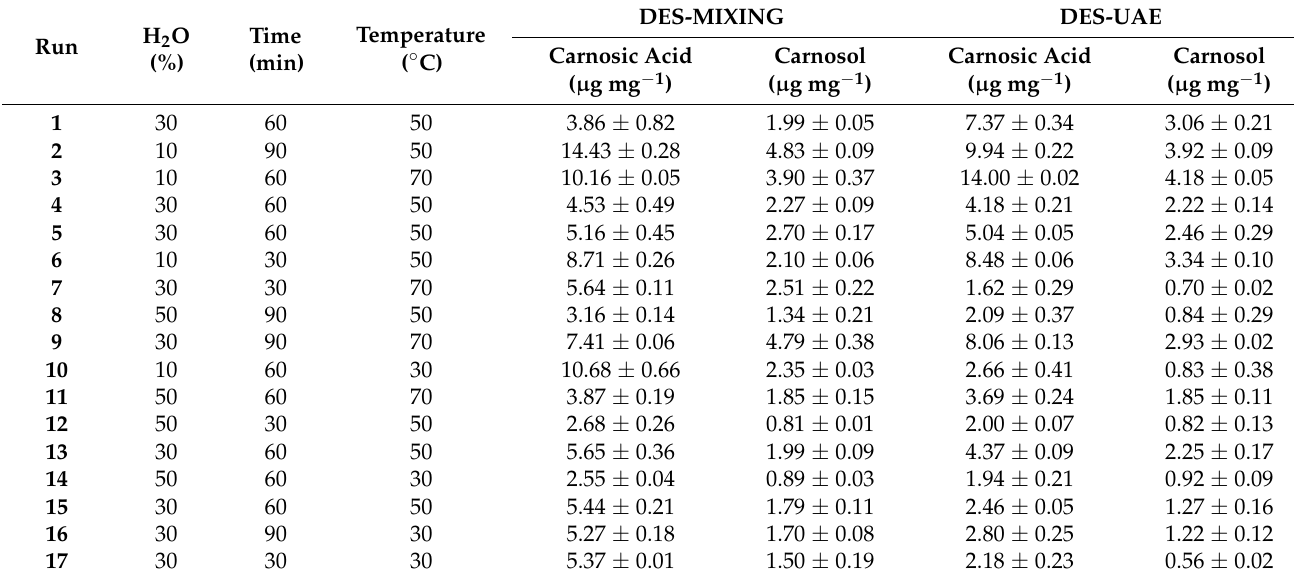
Table 1. Experimental matrix and values ( µ g mg − 1 of the plant material) of observed response for the extraction with choline chloride:lactic acid (1:2 molar ratio) obtained by stirring with heating and by ultrasound-assisted extraction (UAE). The results are expressed as mean value ± standard deviation ( n =